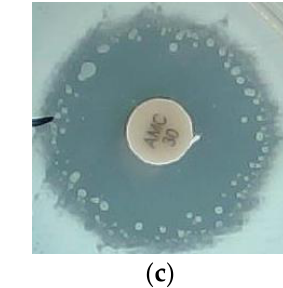
Figure 3. Photo of the inhibition zone produced by Salmonella Typhimurium with: ( a ) initial reference method with Mueller – Hinton agar from Becton, Dickinson and a disc from Bio-Rad with no sign of heteroresistance; ( b , c ) sign of heteroresistance when using bioMérieux Mueller – Hinton Enterobacterales agar (bioMérieux Inc., Marcy l’ Étoile, France) and an AMC disc from i2a (i2a, Montpellier, France).